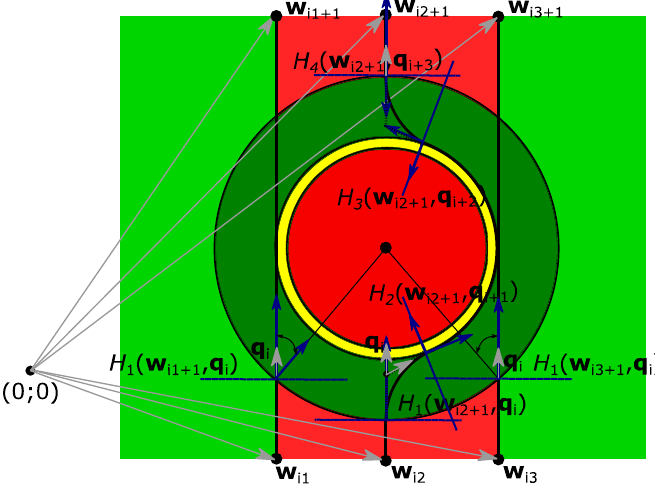
Figure 5. Decision areas for UAV ground obstacle avoidance algorithm: dark red—prohibited to fly area; yellow—additional safety area due to the calculations errors; dark green—area for the UAV to make an initial turn for the ground obstacle avoidance; light red—UAV approaching from there will need to make an obstacle avoidance; light green—UAV approaching from there will not need to make an obstacle avoidance